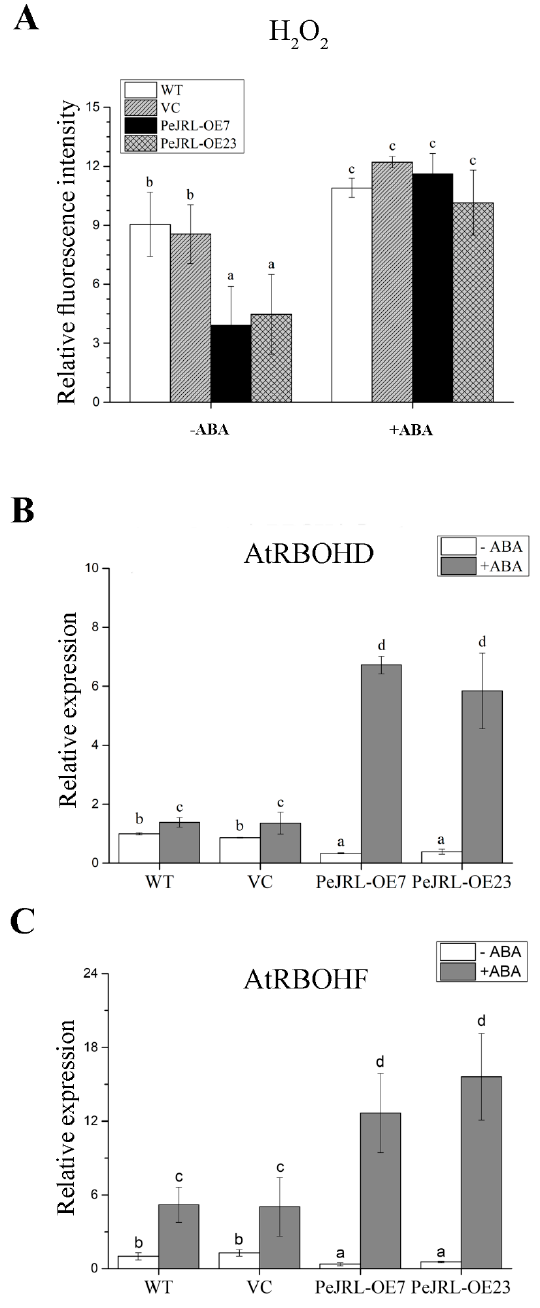
Figure 11. Effect of ABA (5 µ M, 12 h) on root H 2 O 2 production and AtRBOHD and AtRBOHF expression in wild-type (WT) Arabidopsis, vector control (VC), and PeJRL -transgenic lines (OE7 and OE23) under NaCl stress. ( A ) H 2 O 2 production. Seven-day-old seedlings were transferred to 1/2 MS medium containing 125 mM NaCl supplemented without or with 5 µ M ABA for 12 h. Seedlings were then incubated with H 2 DCF-DA for 5 min. Green fluorescence within cells was detected at the apical region of roots under a Leica confocal microscope. The mean fluorescence intensities of H 2 DCF-DA are shown in control ( − ABA) and ABA-treated roots (+ABA). ( B ) AtRBOHD and ( C ) AtRBOHF expression. AtRBOHD and AtRBOHF transcription were detected with RT-qPCR. The Arabidopsis AtACTIN2 was used as the internal control. Primers designed to target AtRBOHD , AtRBOHF, and AtACTIN2 genes are shown in Supplementary Materials Table S1. Each column corresponds to the mean of seven independent seedlings and columns labelled with different letters (a–d) indicate significant differences at p <